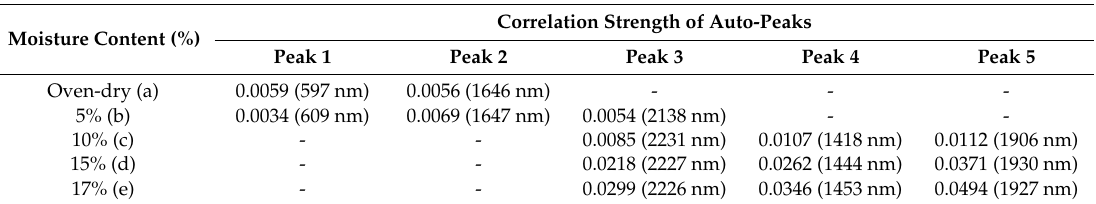
Table 3. Tabulates the correlation strength of the five main auto-peaks for the soil samples with various soil organic matter (SOM) content (i.e., SOM content as perturbation variable): waveband uncertainty = ±5 nm.